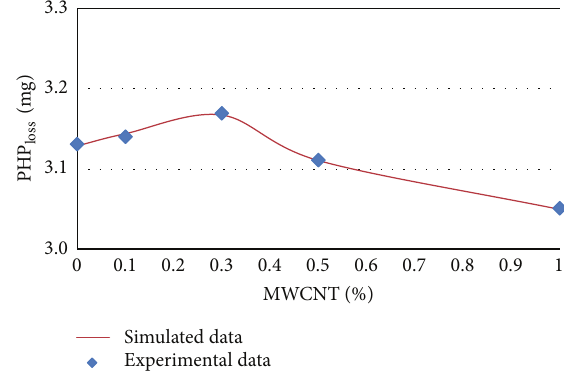
Figure 5: Experimental and simulated values of PHP loss for 7 days by artificial neural networks.